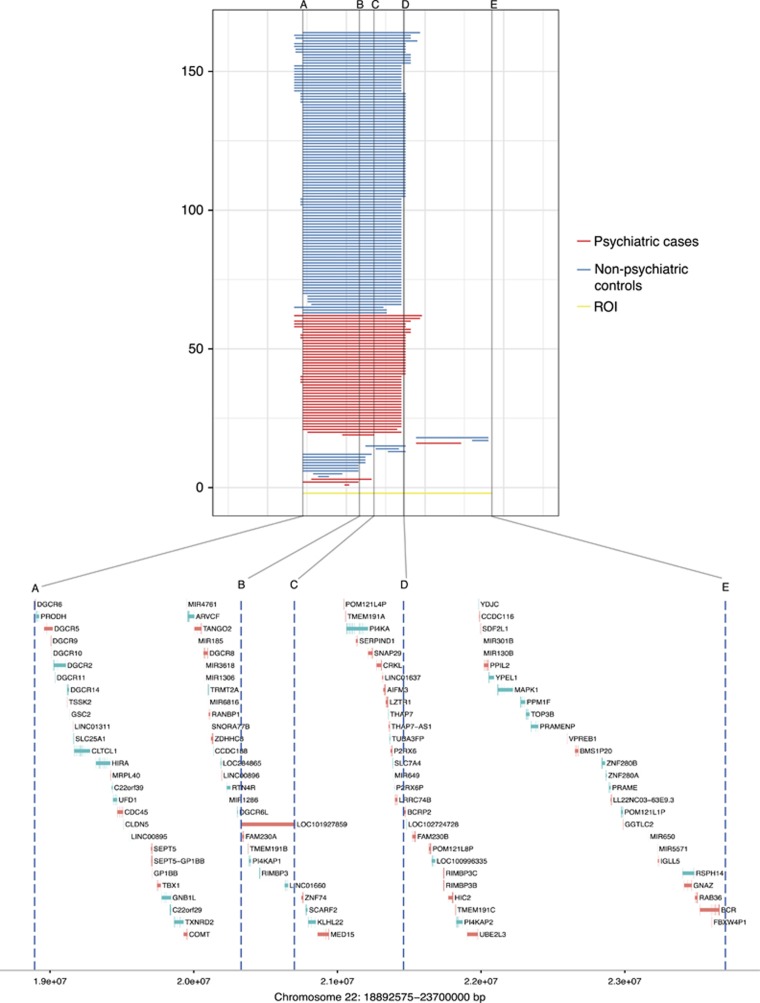
Top panel: Overview of 22q11.2 deletion types obtained by CNV calling from 450 K DNA methylation array for all 164 individuals included in the sample arranged by 22q11.2 deletion type. Horizontal gray lines marked A–E indicates boundaries of different 22q11.2 deletion types. ROI indicates 22q11.2 deletion region of interest as defined by genotyping data for these individuals. Bottom panel: Overview of RefSeq genes (hg19) located in the region of 22q11.2 deletion. Orange color indicates genes transcribed from the sense strand; blue color indicates genes transcribed from the antisense strand. CNV, copy number variant.